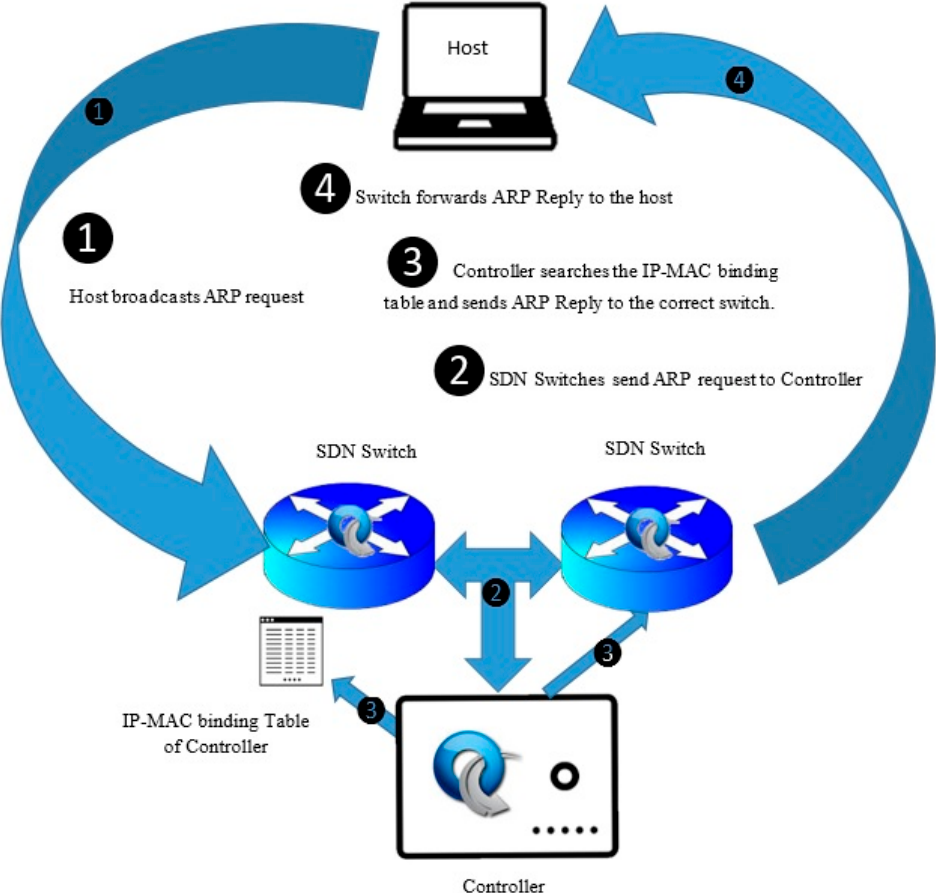
Figure 3. Proxy ARP in SDN.